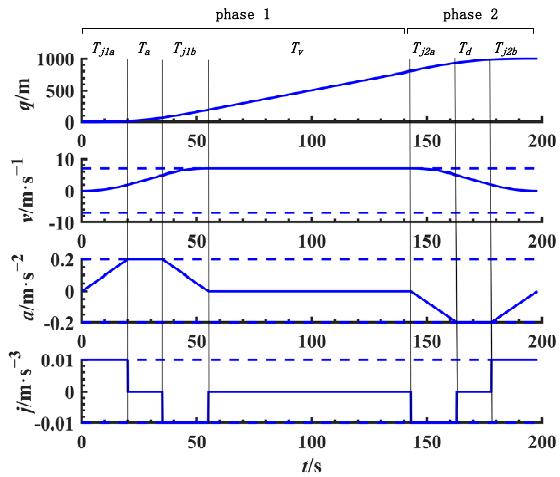
Figure 12. Typical profiles for position, velocity, acceleration, and jerk for the double S trajectory. Phase 1: Acceleration and constant velocity phase